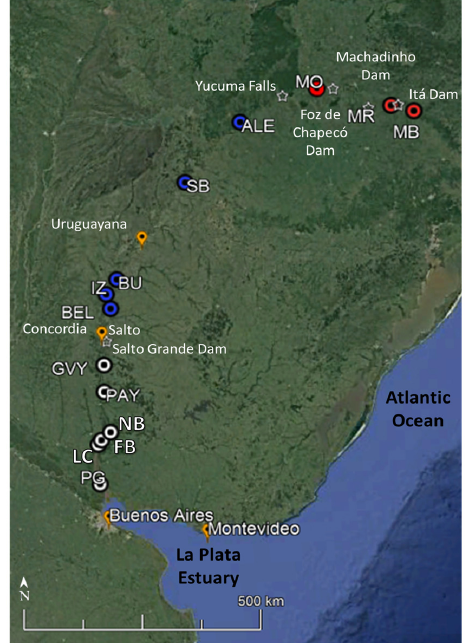
Figure 1. Location of the 14 sampling sites of the Uruguay River. The Uruguay River sampling sites are coloured according to the different sections; red: Upper; blue: Middle, and white: Lower. MB: Barracão, at the confluence of Canoas River and Pelotas River; MR: Marcelino Ramos; MO: Mondaí; Ale: Alecrim; SB: São Borja; BU: Bella Unión; IZ: Isla del Zapallo island; Bel: Belén; GVY: Guaviyú; Pays: Paysandú; NB: Nuevo Berlín; FB: Fray Bentos; LC: Las Cañas, and PG: Punta Gorda, at the mouth of the Uruguay River. Major towns (orange) and waterfalls and dams (white star) are represented in the figure.